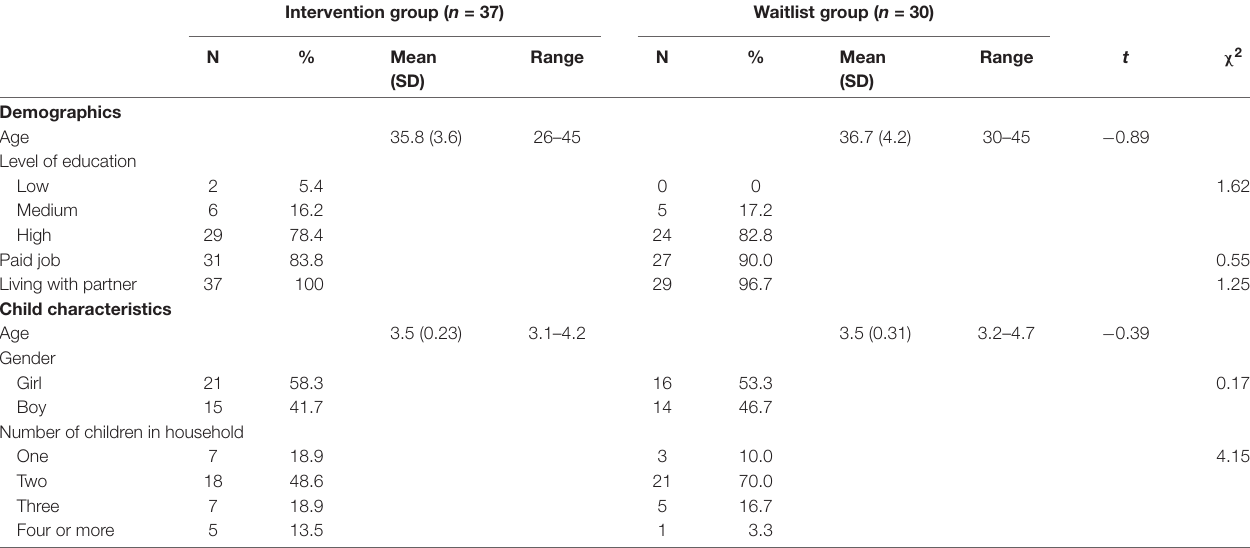
TABLE 2 | Demographic characteristics of the participating mothers ( n = 67).